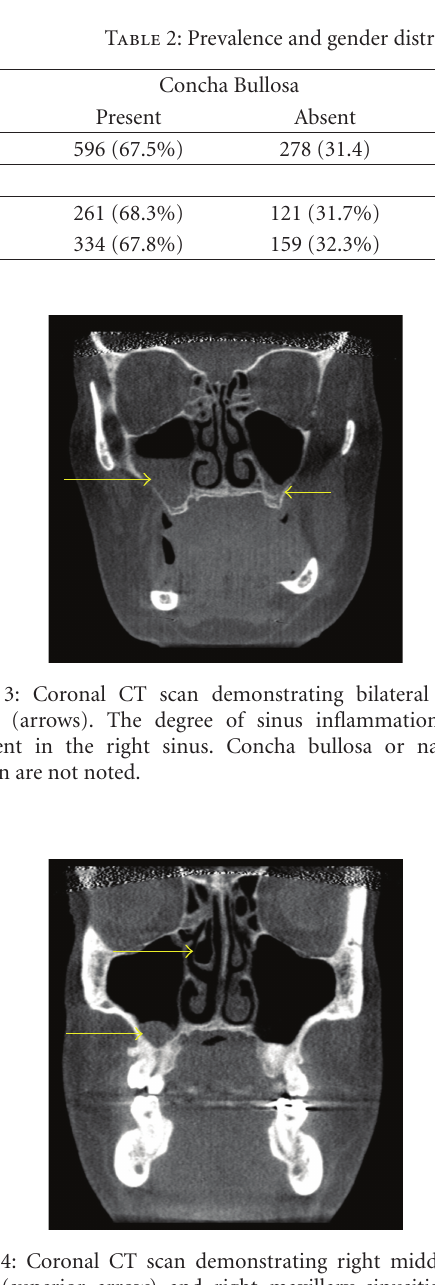
Figure 6: Coronal CT scan demonstrating bilateral middle concha bullosa (superior arrows) in combination with bilateral maxillary sinusitis (inferior arrows). Note the left concha bullosa (right superior arrow) is located slightly superior to the left concha. There is similar degree of sinus inflammation in both maxillary